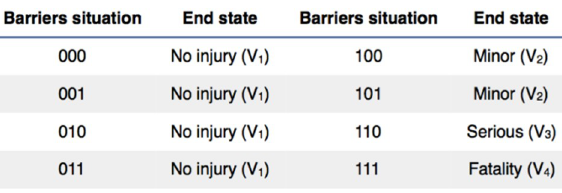
Figure 25. End states in function of the mitigative safety barriers situation.